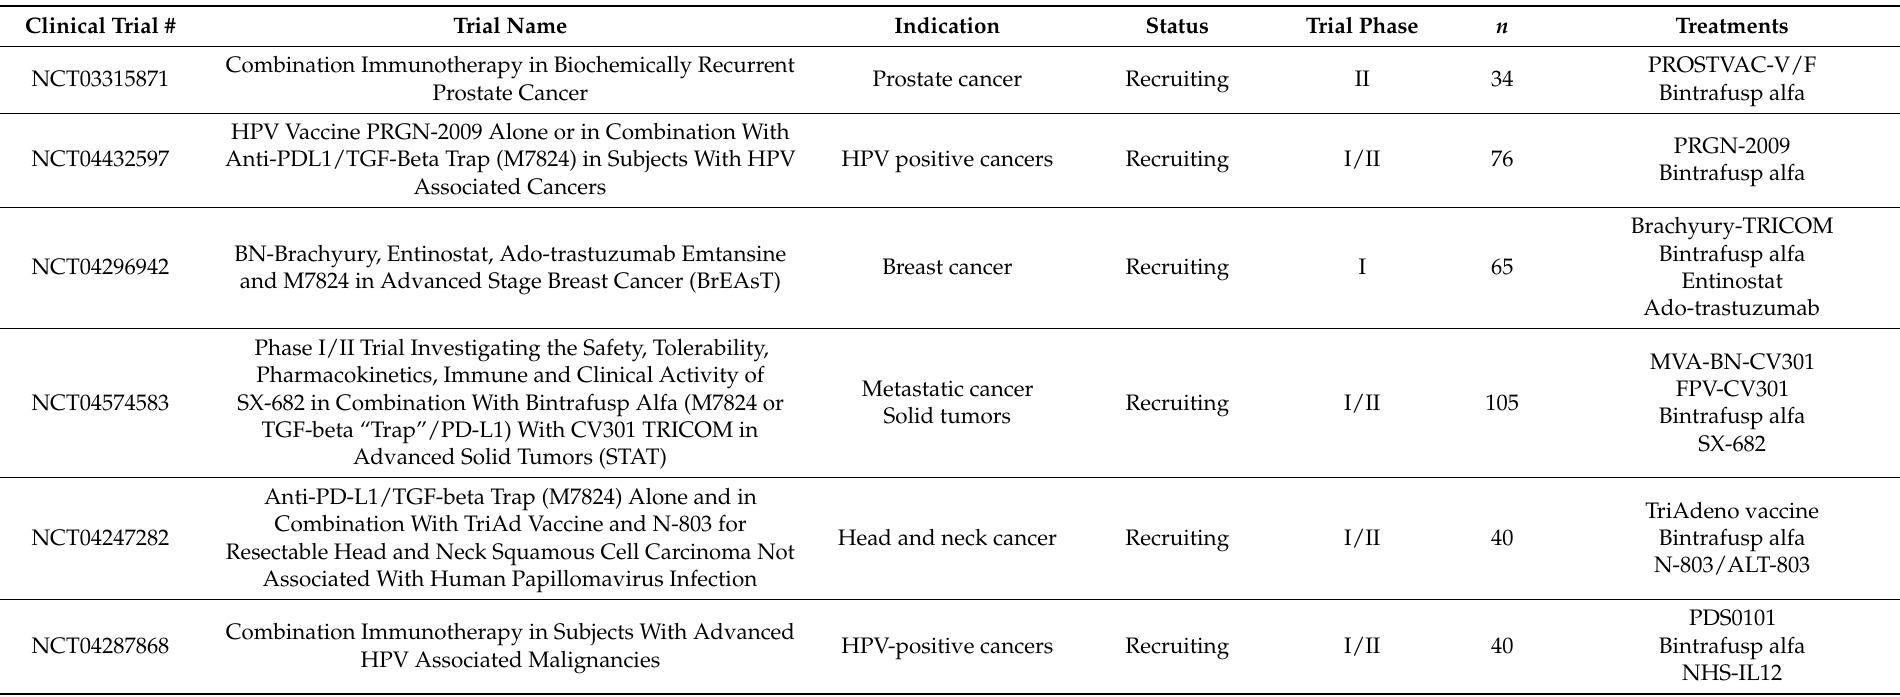
Table 3. Third-generation combination